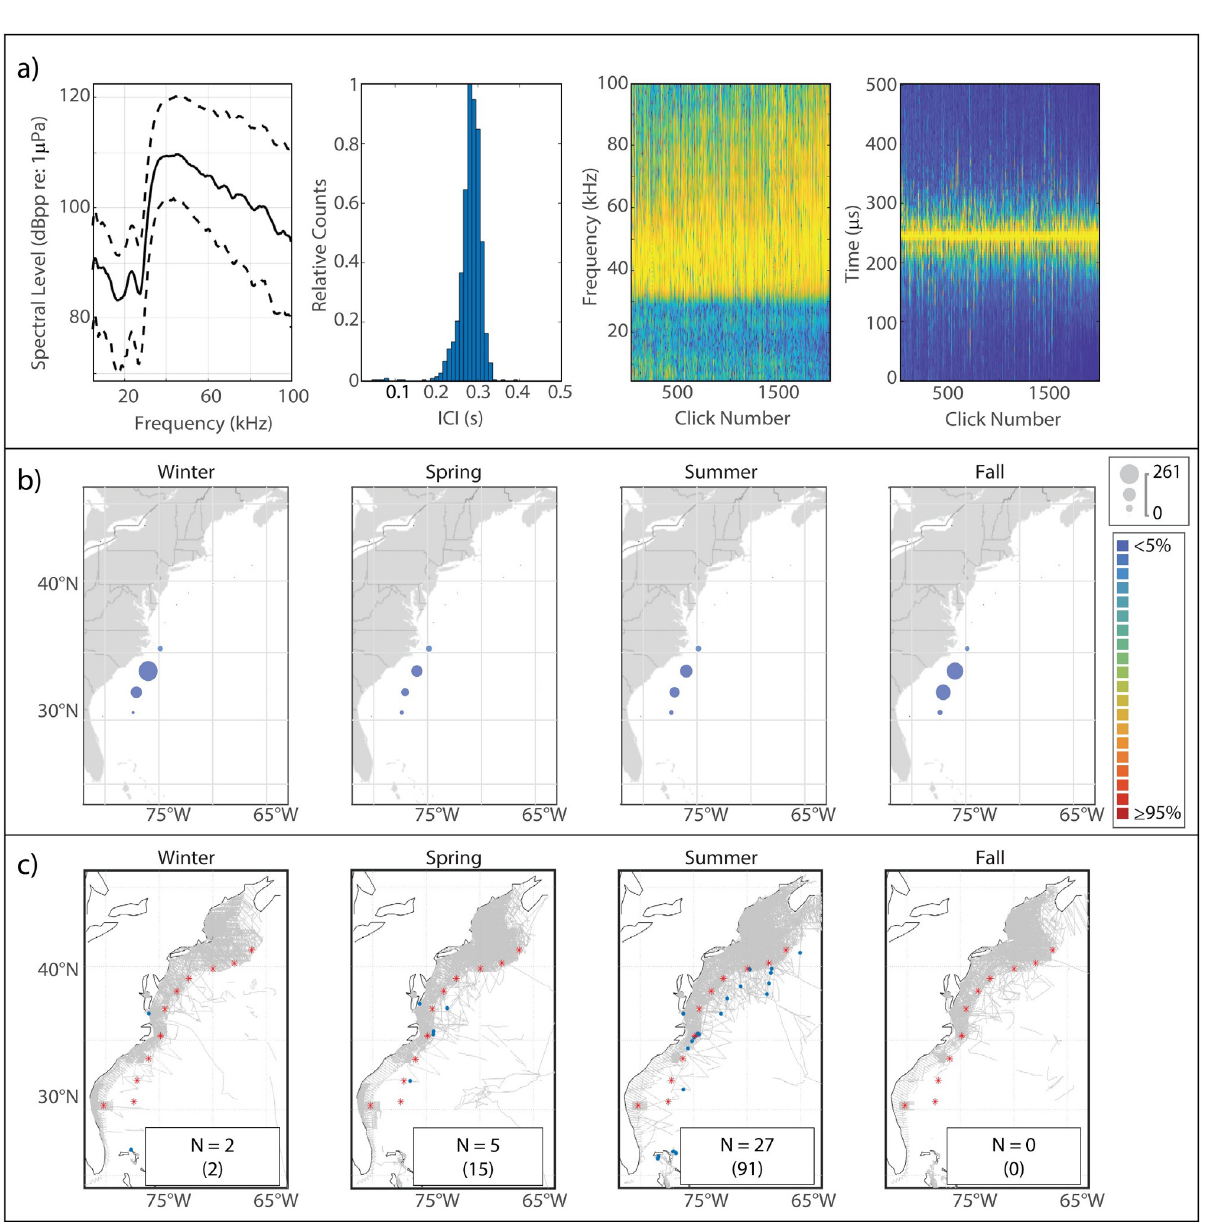
Fig 5. Results for Gervais’ beaked whale showing click type (a), acoustic presence (b), and historical sightings (c). Subplots as in Fig 2.